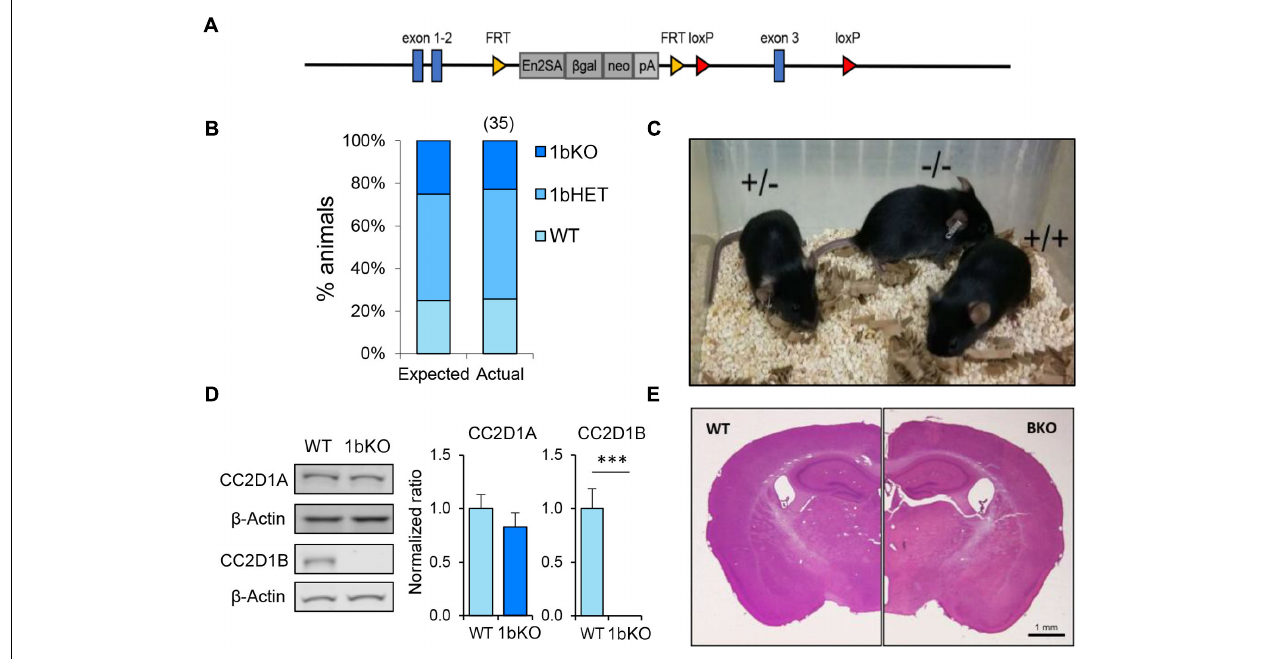
FIGURE 1 | Cc2d1b KO mice are viable and fertile and present normal anatomical development of the brain. (A) Gene trap containing engrailed two splice acceptor (En2SA) sequence followed by a β -Galactosidase cassette ( β gal) and a neomycin resistance cassette (neo) is flanked by flippase recognition target (FRT) sites between exons 2 and 3. LoxP sites for Cre recombinase targeting flank exon 3. (B) 1bKO mice are born in predicted Mendelian ratios (number of pups indicated above in parentheses; data from 5 litters) and (C) are indistinguishable from WT and 1bHET mice. (D) Immunoblot analysis of CC2D1A and CC2D1B expression in WT and 1bKO mice. Normal levels of CC2D1A and a complete absence of CC2D1B are shown in the 1bKO mice. (E) The size and organization of the adult 1bKO brain is indistinguishable from WT brain stained with hematoxylin and eosin. Scale bar: 1